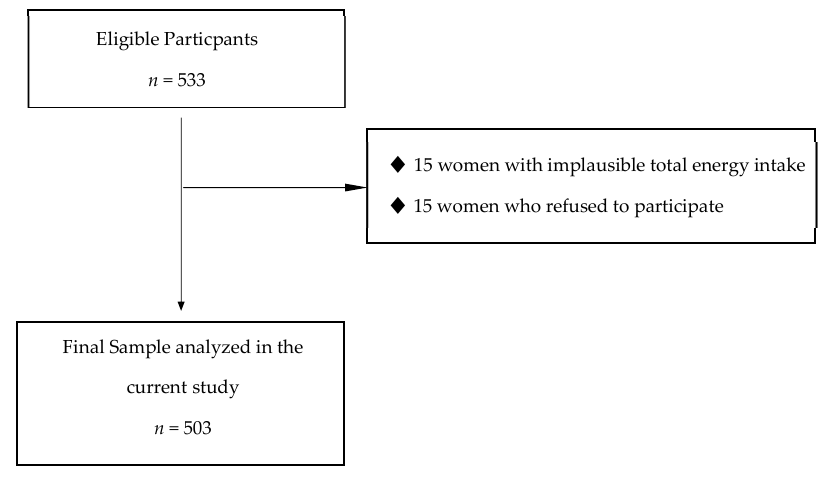
Figure 1. Study Figure 1. Study Flow-Chart.